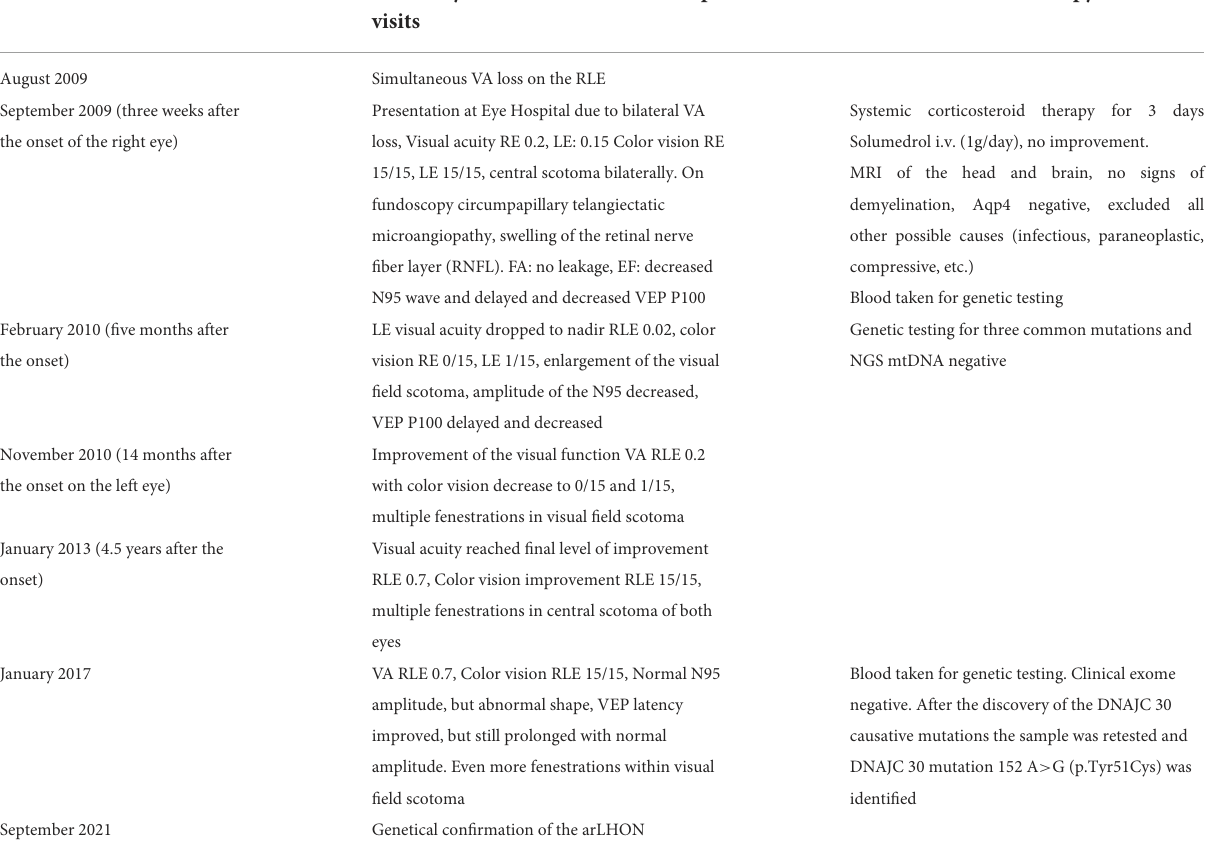
TABLE 2 Medical history and disease progression in the Case